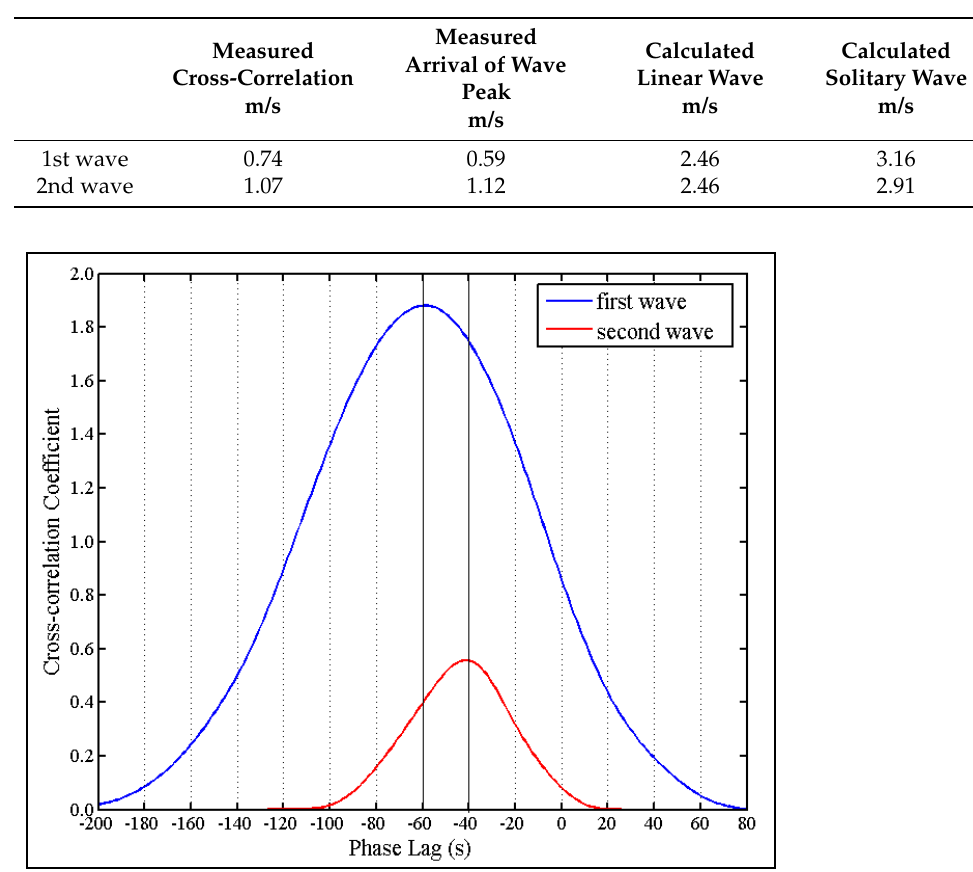
Figure 5. Cross-correlation of the two tsunami-like waves. For the first wave, the maximum cross- correlation coefficient corresponds to a phase shift of 59 s. For the second wave, the maximum cross-correlation coefficient corresponds to a phase shift of 41 s.